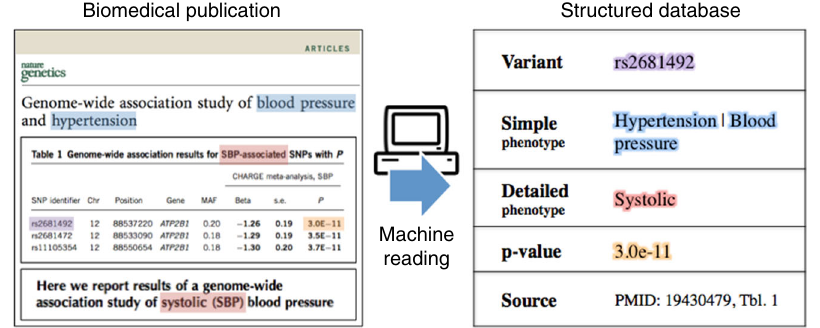
Fig. 1 The automated information extraction system used to compile GWASkb. The GWASkb system takes as input a set of biomedical publications retrieved from PubMed Central (left) and automatically creates a structured database of GWAS associations described in these publications (right). For each association, the system identi fi es a genetic variant (purple), a high-level phenotype (pertaining to all variants in the publication), a detailed low-level phenotype (speci fi c to individual variants, if available; red), and a p value (orange). Acronyms are also resolved